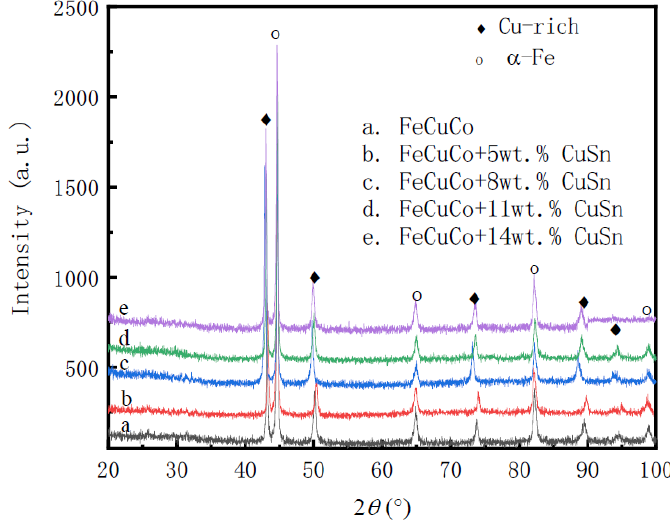
Figure 3. The XRD patterns of sintered FeCuCo alloys. It can be seen from Figure 4 that the five kinds of pressureless sintered Fe-Cu-Co alloys have passivation zones at potentials above − 0.2 V SCE . With the increase in Cu-Sn addition, the current density in the passivation zone gradually decreases. Specifically, when the voltage is 0 V SCE , the amount of Cu-Sn added is 0, 5 wt.%, 8 wt.%, 11 wt.%,